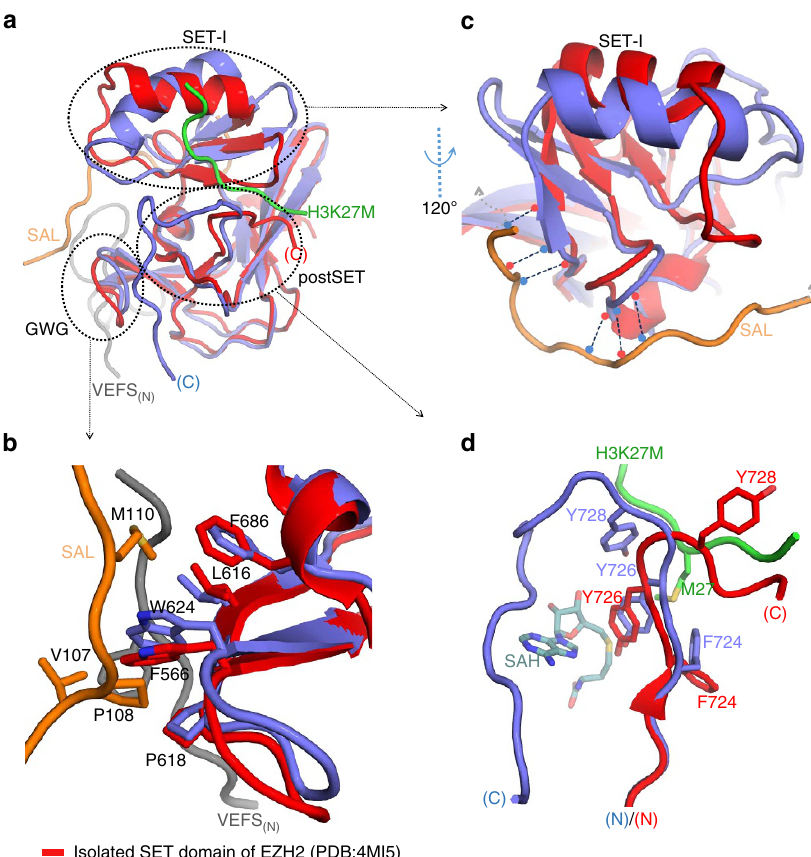
Figure 3 | Stabilization of the SET-I region. The active conformation of the SET domain is stabilized by interactions with the Vefs domain and with the SAL and SRM from the N terminus of EZH2. ( a ) Superposition of the human EZH2 SET domain from the PRC2 complex structure (blue) with isolated domain (PDB 4MI5, red). There are three main regions stabilized by interactions in the complex ( b ). The conserved GxG loop is stabilized by interactions with the SAL subdomain from the N terminus of EZH2 (orange) and the region N-terminal to the SUZ12 Vefs domain (grey). ( c ) The SAL subdomain region of EZH2 (orange) also makes a series of main chain interactions with the SET-I region, contributing to the stabilization of the domain and the ordering of the active site. ( d ) There is a significant change in the conformation of the C terminus of the SETdomain in the complex to support the completion of the active